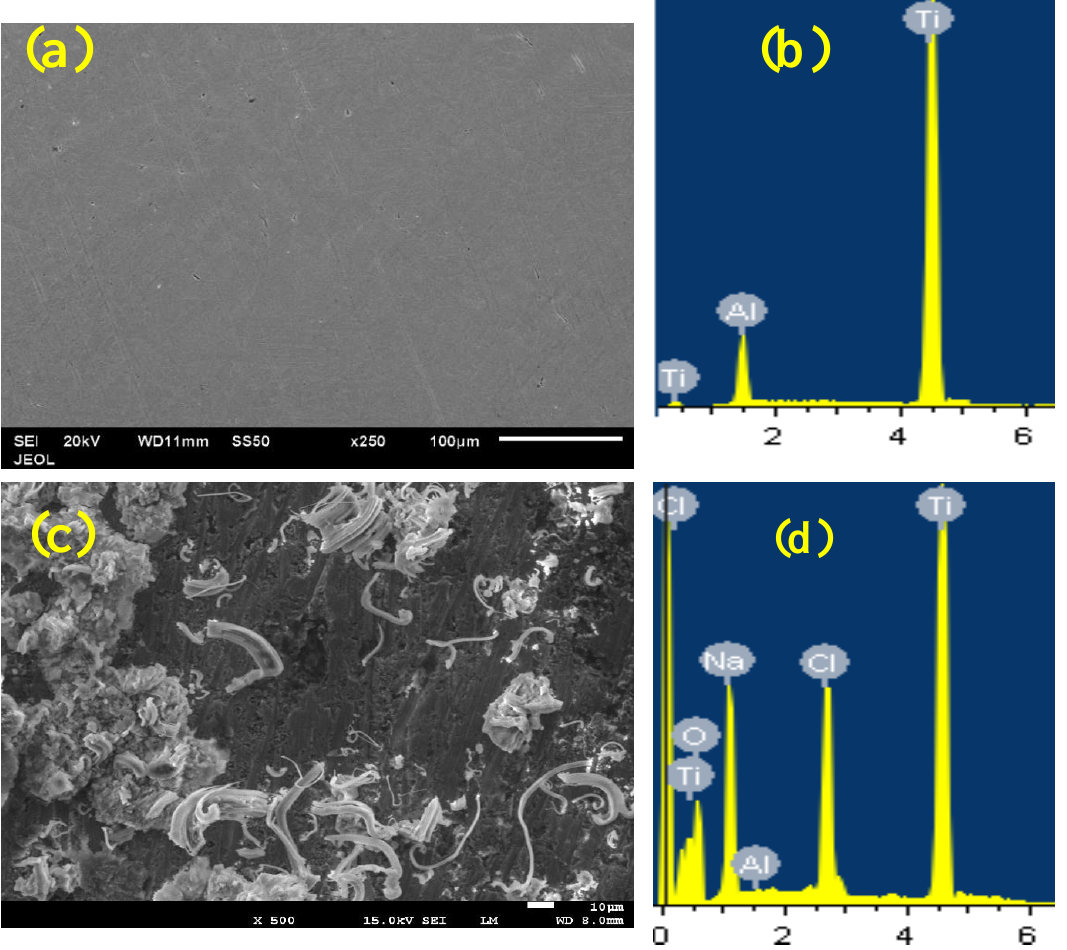
Figure 12. ( a ) SEM and ( b ) EDX analysis for the surface of sintered Ti-6%Al alloy before its immersion; ( c ) SEM and ( d ) EDX analysis for the surface of the corroded Ti-6%Al alloy that was immersed in 3.5% NaCl solution for 48 h before stepping the potential at 300 mV for 30 min.